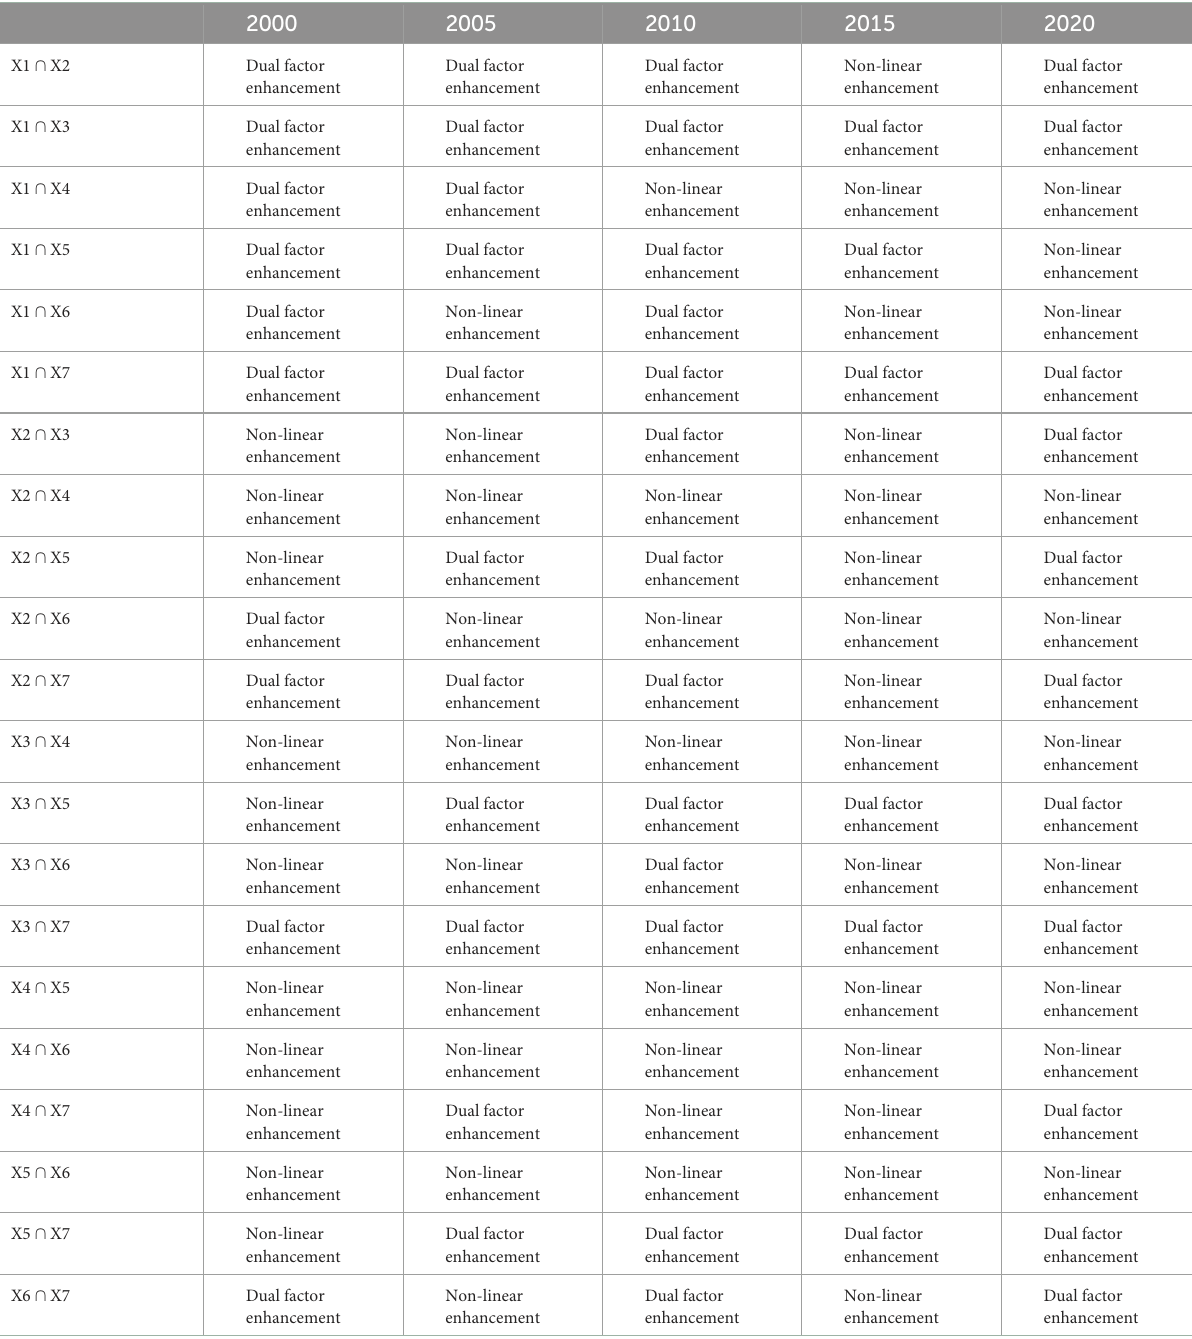
TABLE 5 Interactive detection results of influencing factors of integrated urban-rural